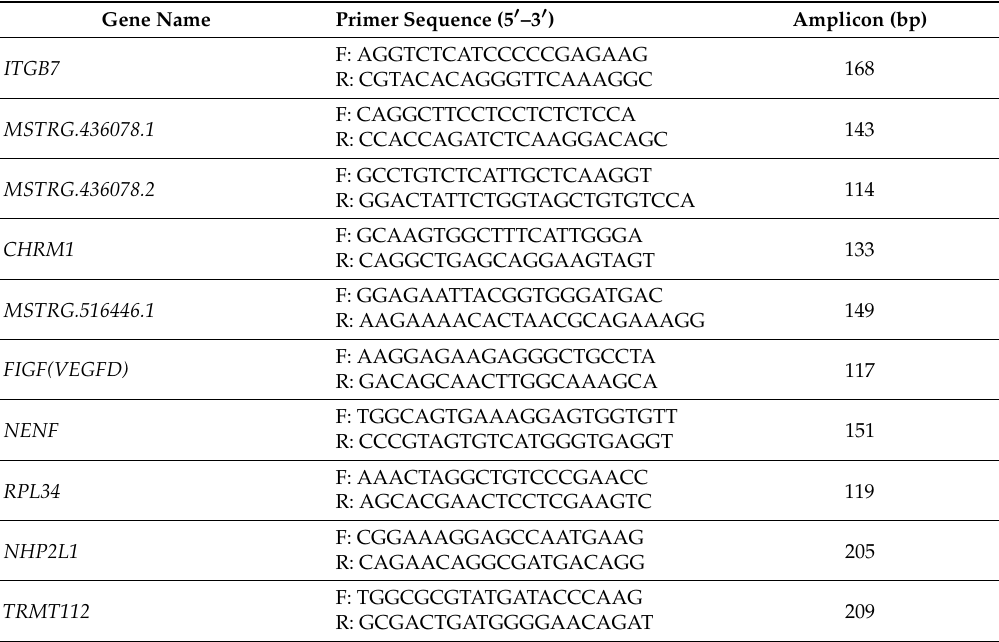
Table 3. Primers used for qRT-PCR and